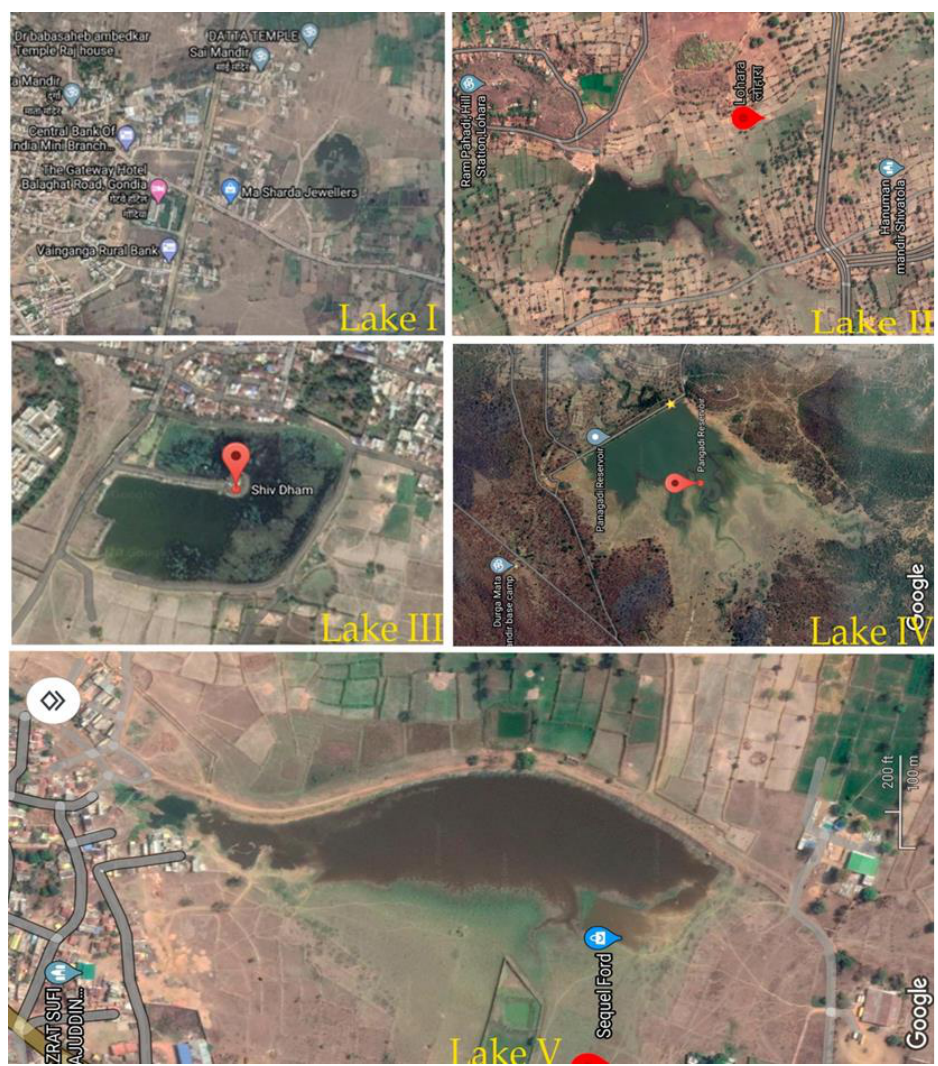
Figure 1. Satellite images of selected sites: Lake I [19], Lake II [20], Lake III [21], Lake IV